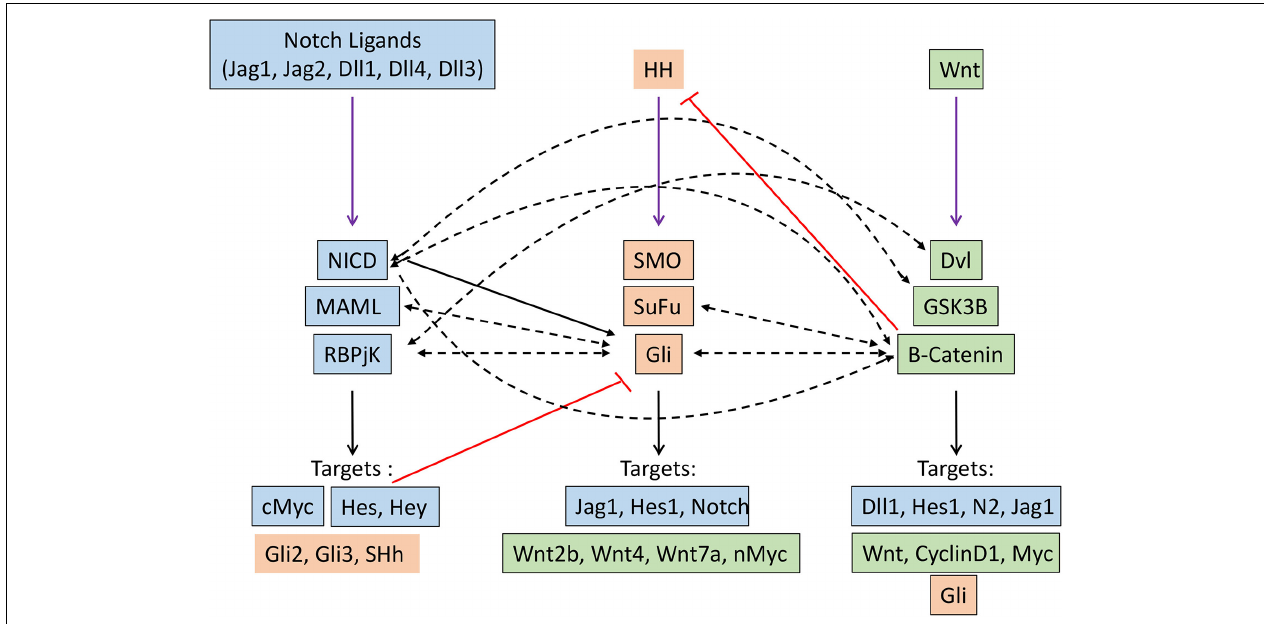
FIGURE 2 | Crosstalk between Notch (blue), Hedgehog (orange) and Wnt (green) signaling pathways in cancer. Black arrow indicates transcriptional regulation. Dashed black arrows indicate direct interactions. Red lines indicate inhibitory